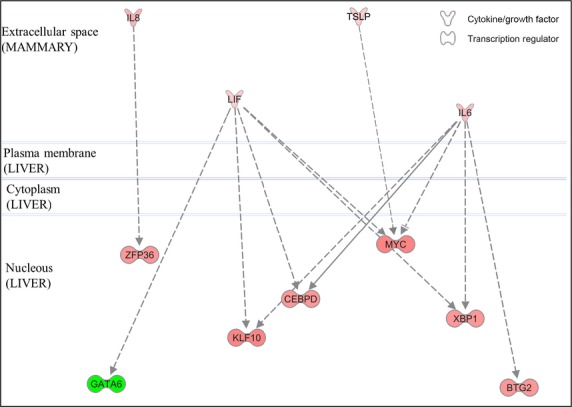
Networks among cytokines differentially expressed in the mammary gland and transcription regulators differentially expressed in liver at 2.5 h after intra-mammary LPS challenge. Figure generated by IPA. Red color denotes upregulation due to LPS and green downregulation due to LPS.